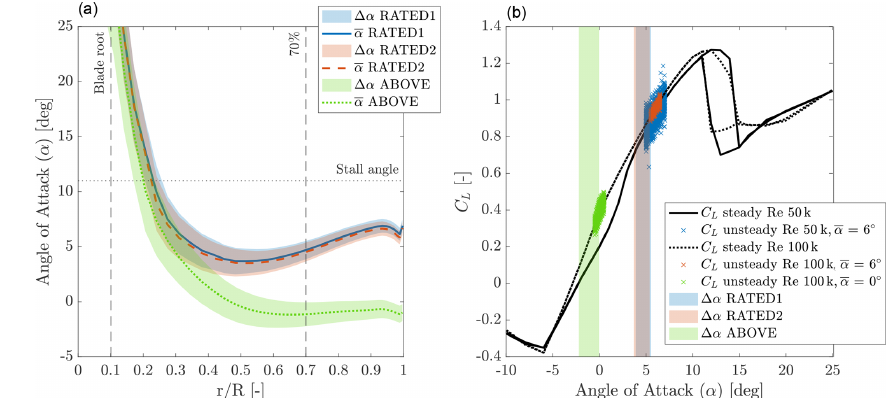
Figure 2. Design of the full-turbine experiment based on 2D airfoil data. (a) The average angle of attack ( α ) and maximum variation due to imposed surge motion ( (cid:49)α ) as a function of non-dimensional radial position ( r/R ) for the turbine-model blade in the three operating conditions of the experiment. The dashed vertical lines indicate the radial position at which the circular cross section ends (blade root) and the one at 70% (rotor radius). (b) The maximum variation in angle of attack at 70% rotor radius is compared with the steady and unsteady lift coefficients from 2D experiments. Lift data were obtained at Reynolds numbers and angle of attack values representative of those experienced by the turbine model blade in the operating conditions of the full-turbine experiment. Here, unsteady data are aligned with the steady ones and do not show any nonlinear behavior. Hence, surge motion is not expected to cause unsteady airfoil aerodynamics but rather rotor-level unsteadiness.